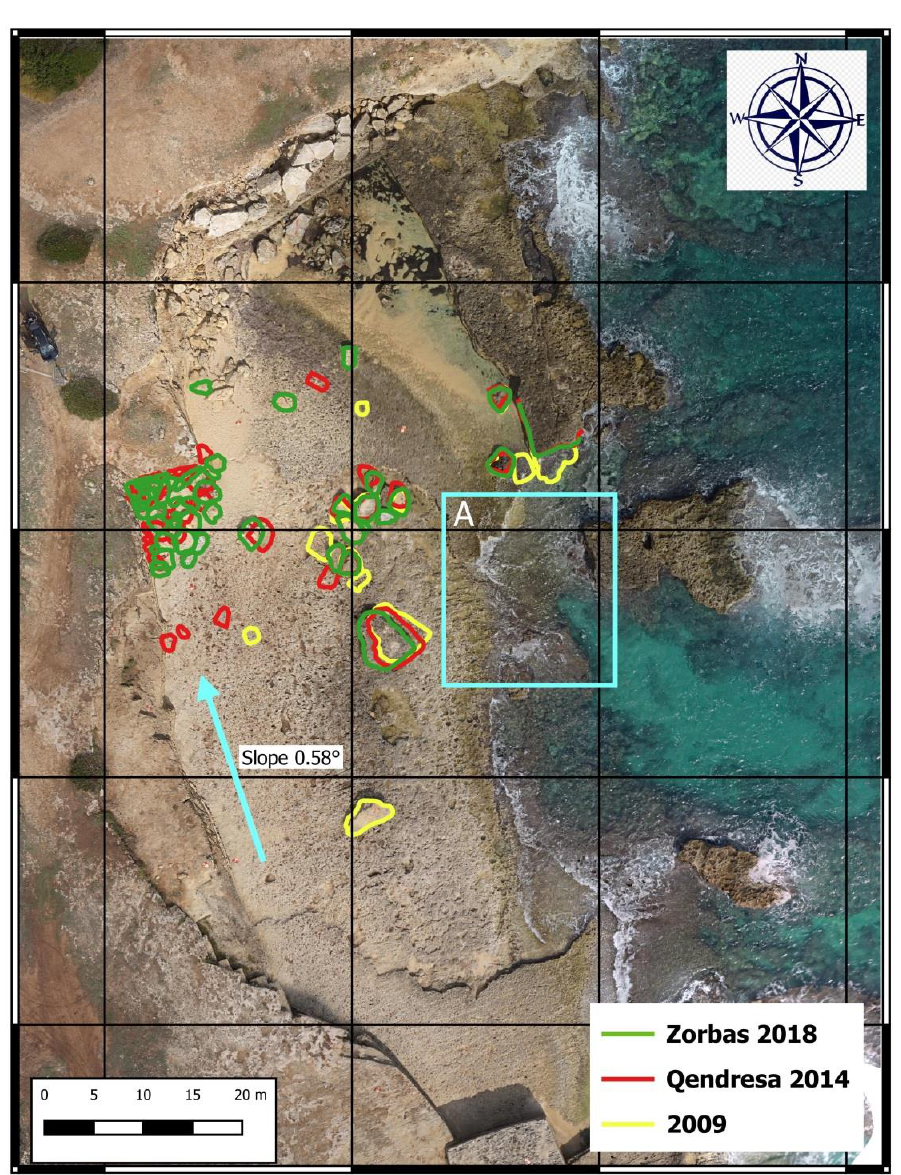
Figure 10. Boulders displaced by the impact of medicanes Qendresa and Zorbas; the rectangle marks the area where boulders have been detached from the coastline, and the arrow indicates the direction of the flow generating boulder deposit on the edge of the quarry.